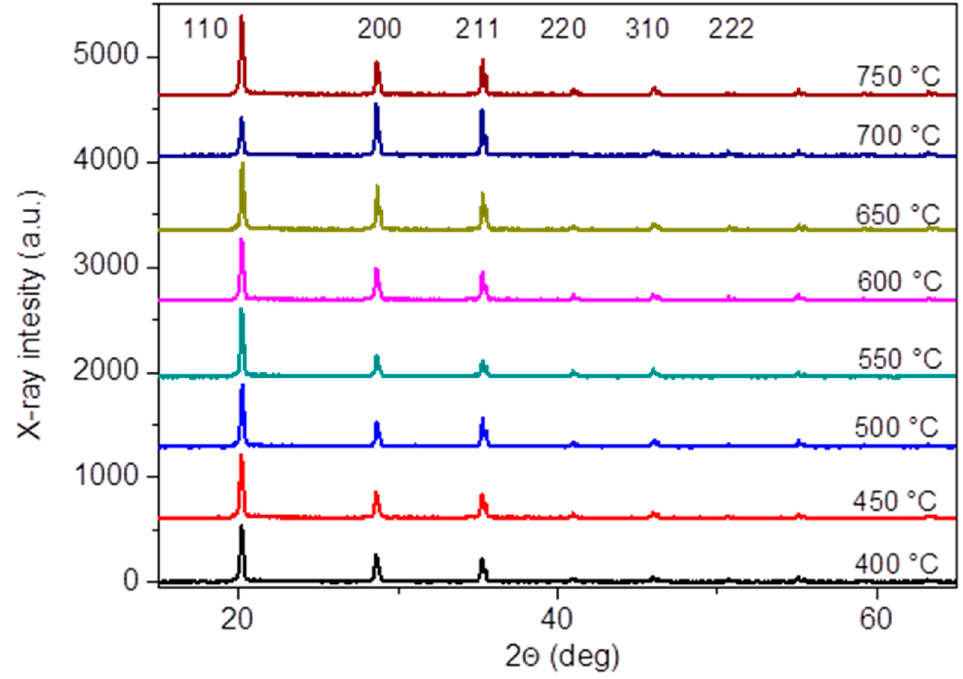
Figure 10. XRD patterns of EUROFER97 steel cold-rolled with CR ratio of 80% and heat-treated at increasing temperatures from 400 to 750 °C with steps of 50 °C. Table 3. Relative intensities of XRD peaks of EUROFER97 steel cold rolled with CR ratio of 80% and heat-treated for 1 h at the reported temperatures (from 400 to 750 °C in steps of 50 °C). The values have been determined from patterns in Figure 10. Data from the file 6-696 of the JCPDS database [59] referring to Fe with randomly oriented grains and of deformed but not treated steel are reported for comparison.